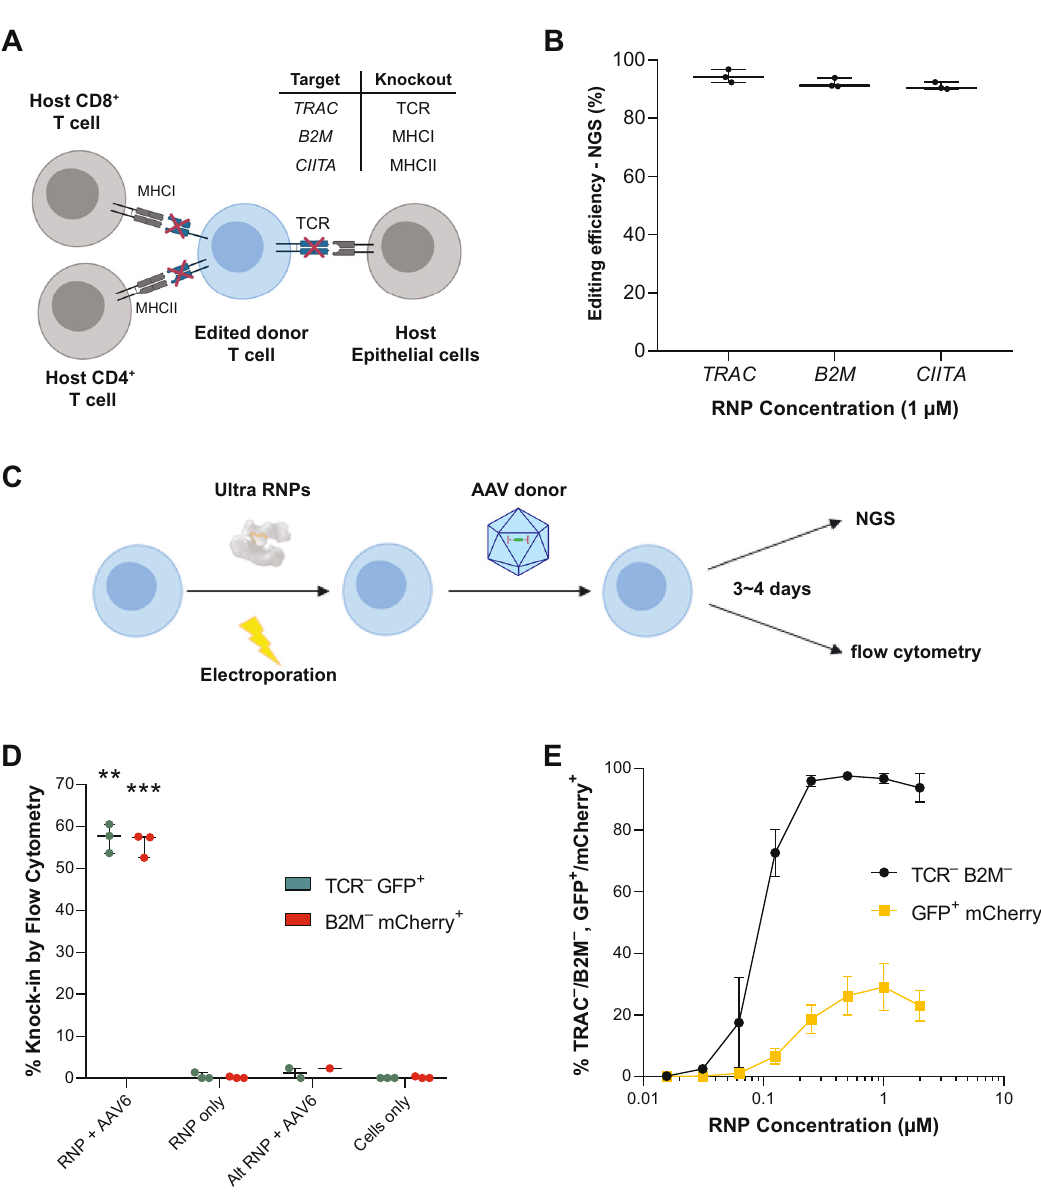
Fig. 5 AsCas12a Ultra enables ef fi cient one-step generation of engineered T cells. A Potential editing strategy for the generation of allogenic T cells. Multiplexed knock-out of TRAC , B2M , and CIITA to reduce the risk of host-versus-graft rejection and graft-versus-host disease responses, respectively. B Simultaneous triple knockout of TRAC , B2M , and CIITA (Class II Major Histocompatibility Complex Transactivator) by AsCas12a Ultra (1 µ M RNP). The optimal guide RNA ( n = 1) targeting each locus was used for multiplex editing. Data are presented as mean values ± SD. C Work fl ow for generation of allogenic T cells with site-speci fi c transgene knock-in by AsCas12a Ultra. The activated T cells were electroporated with Ultra RNPs and transduced